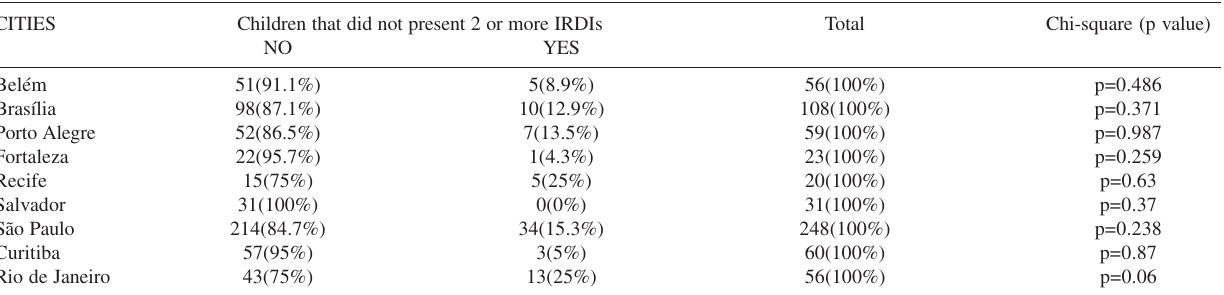
Table 4 - Each municipality was compared to all the others combined. P value obtained did not show any significant difference in the municipalities.